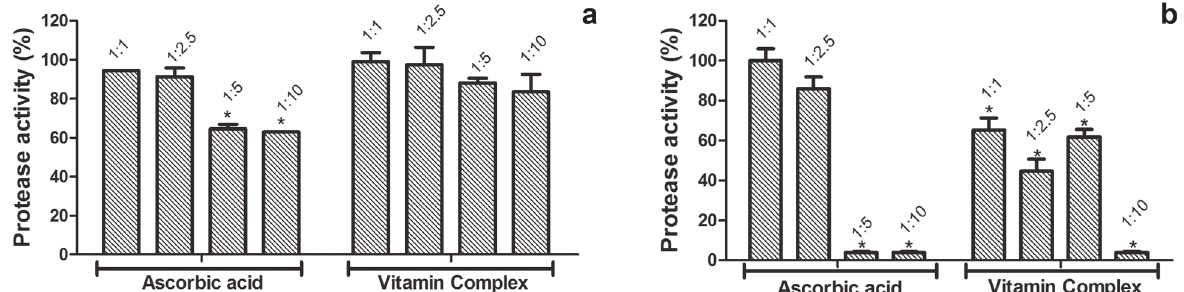
Figure 1 - Vitamins effect on azocaseinolytic activity. ( a ) Bothrops atrox venom previously incubated with ascorbic acid or vitamin complex in different ratios. ( b ) Crotalus durissus terrificus venom previously incubated with ascorbic acid or vitamin complex in different